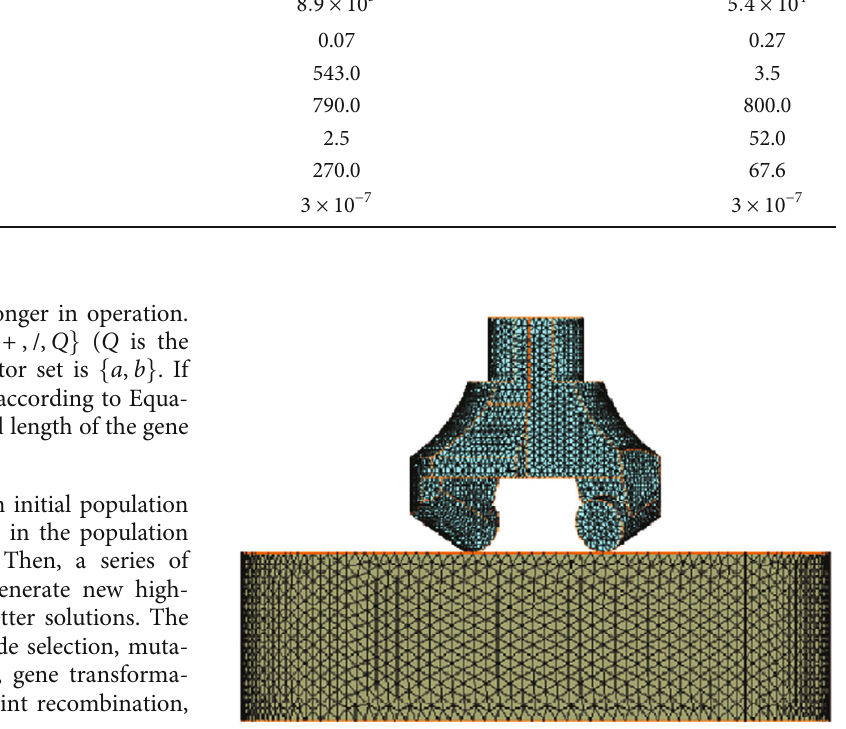
Figure 4: Mesh generation of fi nite-element model for rock breaking of PDC bit with double cutting teeth.